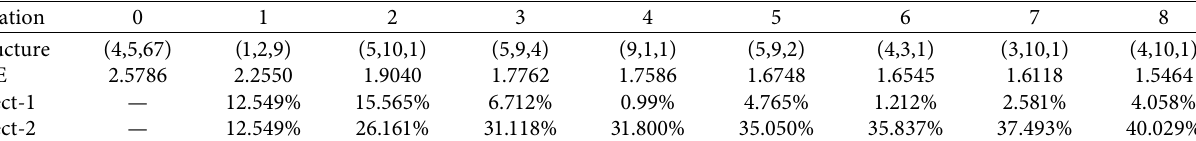
Table 10: AC iteration results on the PDA.